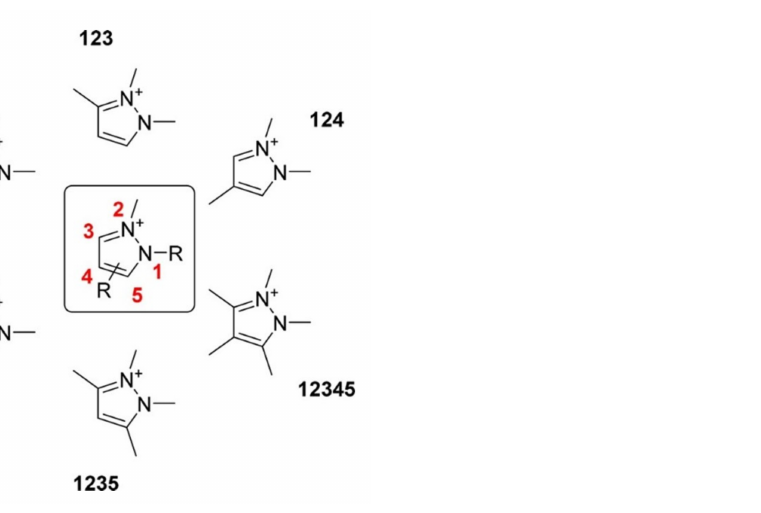
Figure 12. Pyrazolium cations used in the Vasilyev study [88]. Reprinted with permission from [88]. Copyright 2018, American Chemical Society.